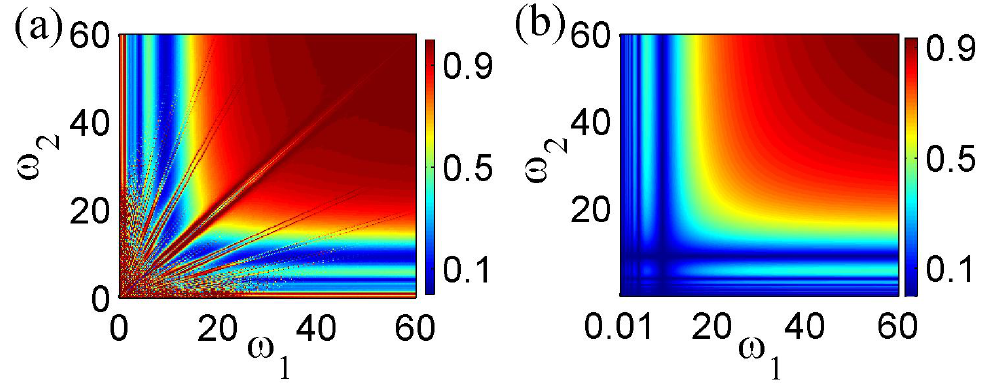
Figure 4. (Color online) ( a ) Numerical results of Π 1 and ( b ) analytical results of coupling intensity | g | as a function of ω 1 and ω 2 in the two-frequency driven scheme. Pairs of bright straight lines ef f in ( a ) denote ν -photon-assisted tunneling effects. Analytical results of coupling intensity agrees well with the numerical ones in the high-frequency approximation. Other parameters are chosen as A 1 = A 2 = 22, φ = 0 and g =